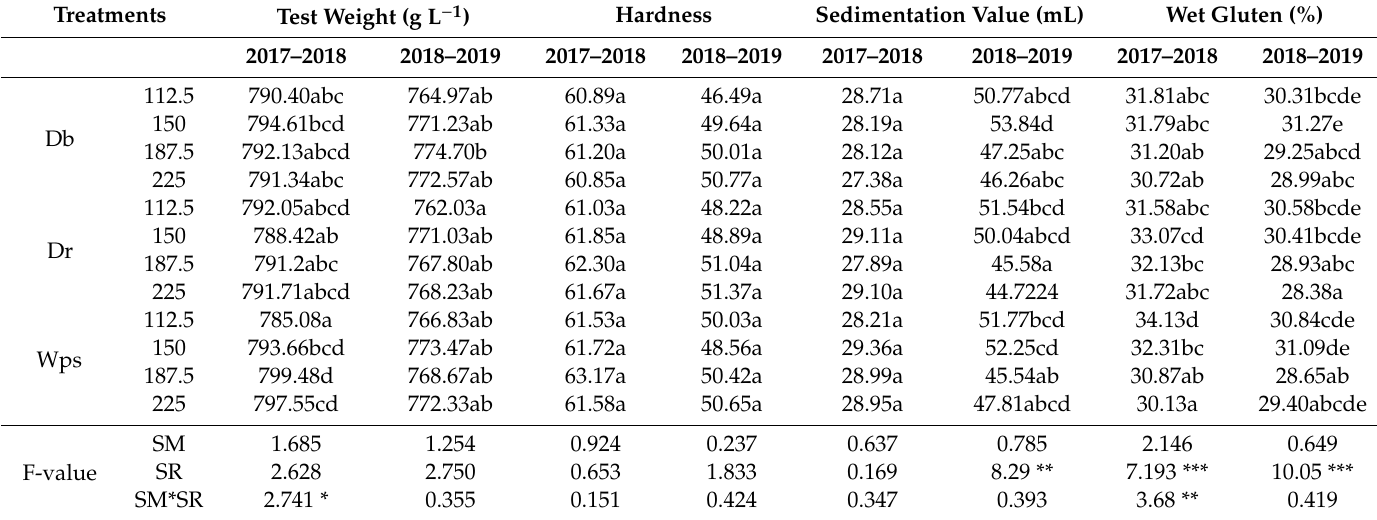
Table 7. The e ff ects of the sowing methods (SM) and seed rate (SR) on the wheat grain quality traits in both cropping seasons.